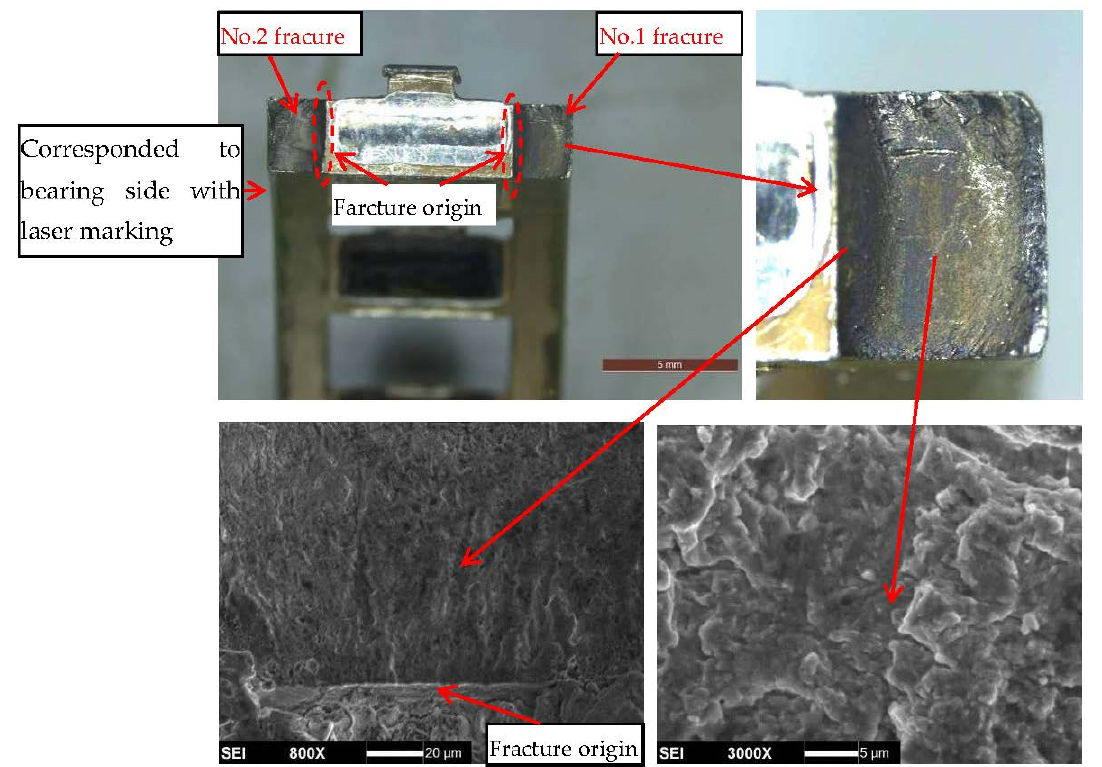
Figure 14. Typical morphologies of the side beam fractures.